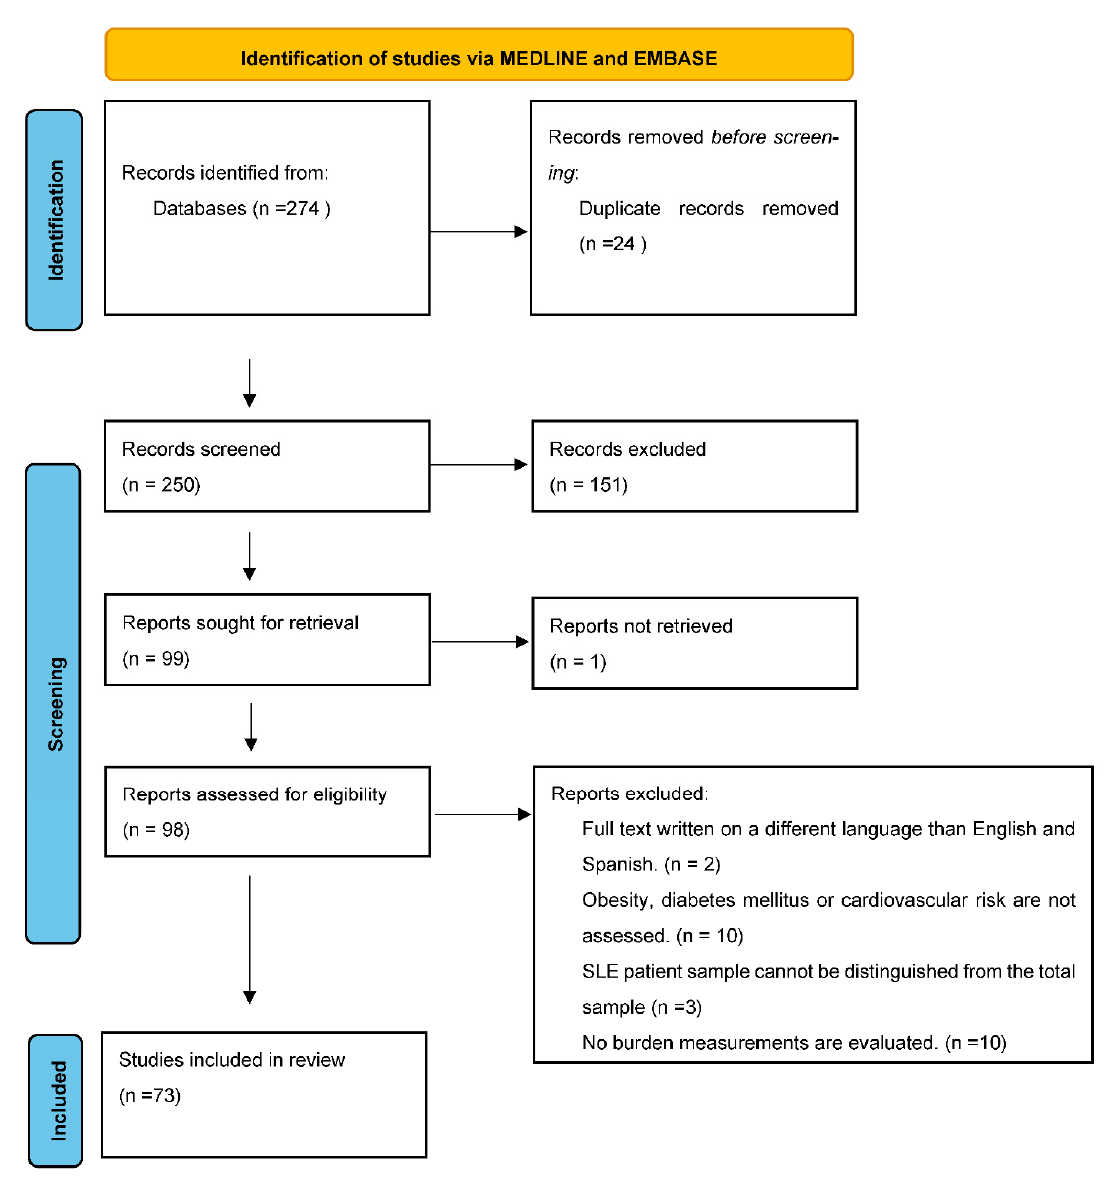
Figure 1. PRISMA flow chart of the article selection process.